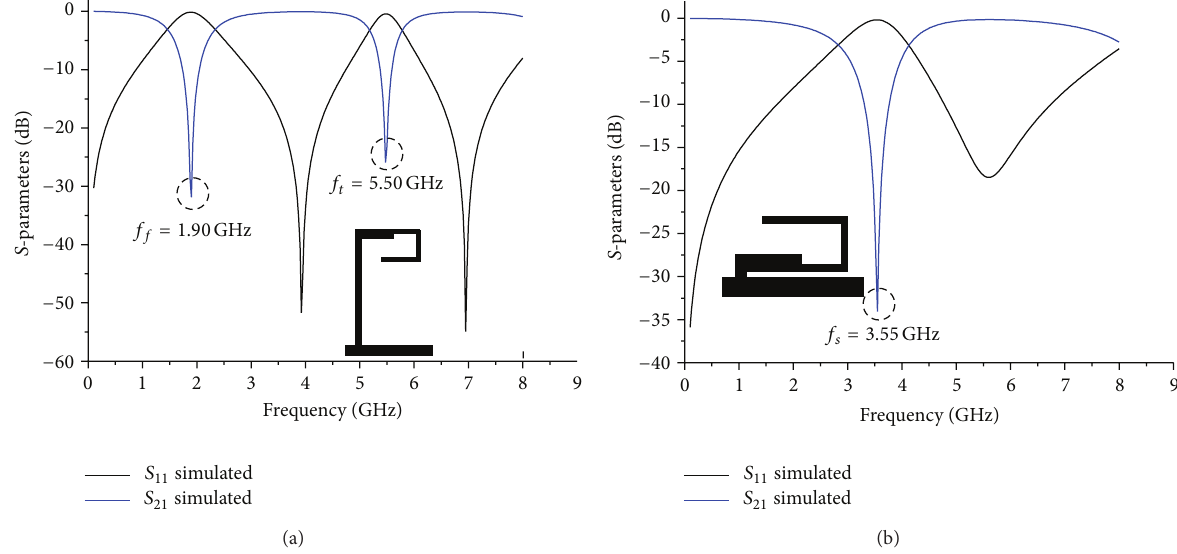
Figure 8: Simulated results of the proposed TSSIR 𝑎 and TSSIR 𝑏 shunt-connected to 50 Ω planar transmission line: (a) TSSIR 𝑎 (b) TSSIR 𝑏 .